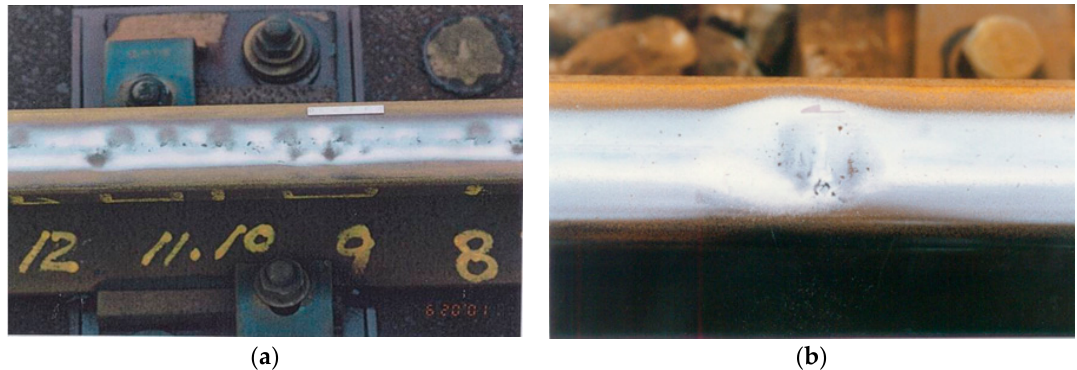
Figure 1. Rail surface defects: ( a ) white etching layer (WEL)-related rail studs (multiple studs); ( b ) a rolling contact fatigue (RCF)-related rail squat (single squat).